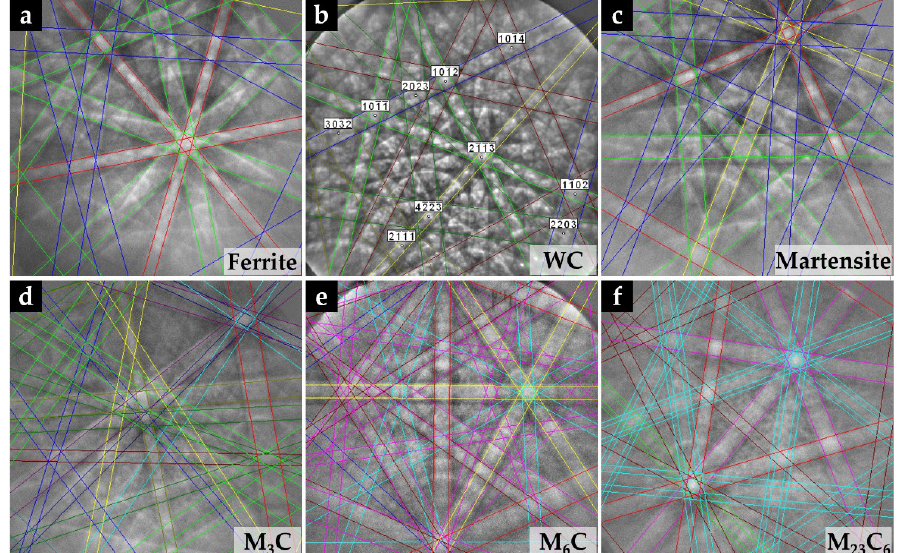
Figure 6. Indexed EBSD patterns corresponding to the phases present at the composite: ferrite (α) ( a ) and WC ( b ), both detected in the CZ1 and CZ2 composite zones; martensite (α’) found in the CZ3 region ( c ); and (Fe,W) 3 C ( d ), (Fe,W) 6 C ( e ) and (Fe,W) 23 C 6 ( f ) detected in the matrix of the composite.